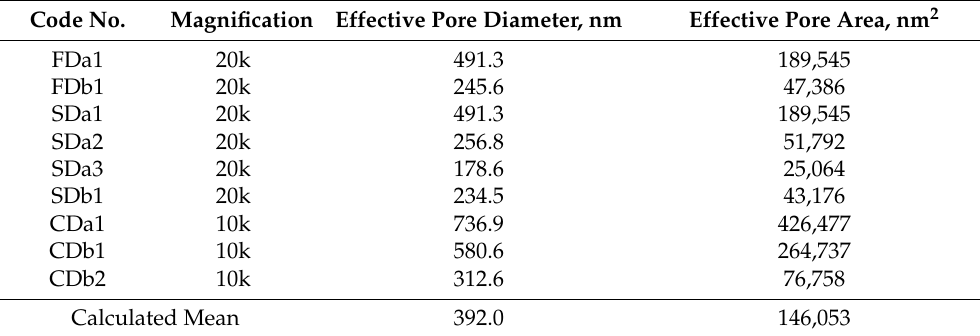
Table 1. Summary of diameter and area on the surface, side and cross ‐ section of biomaterial from various magnifications.